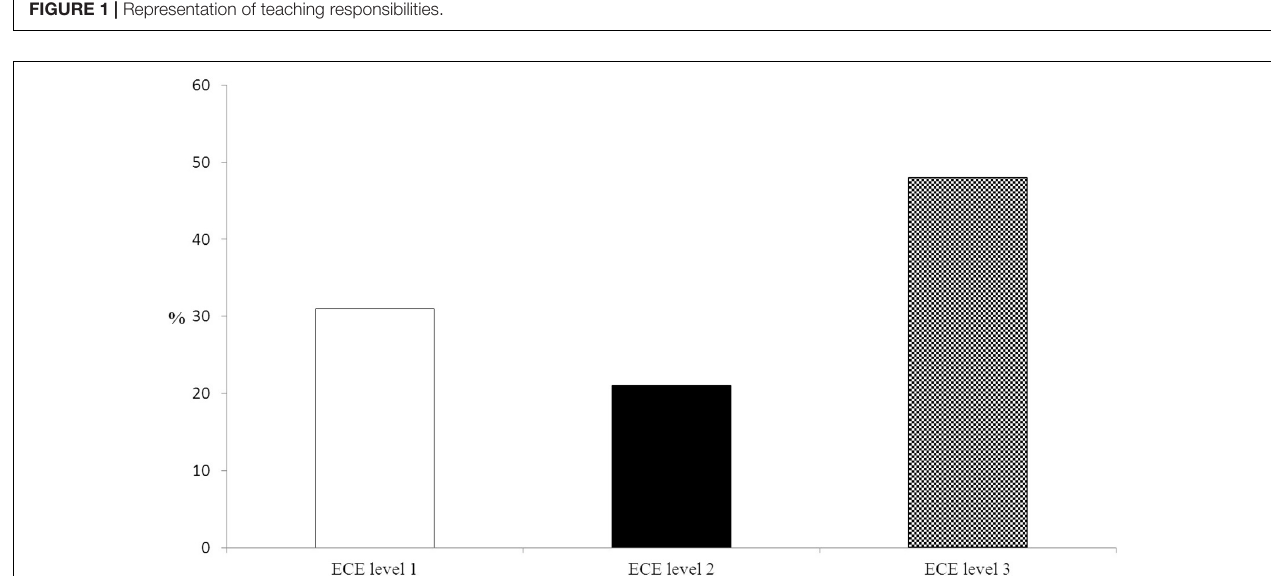
FIGURE 2 | Age when topics related to responsibilities were